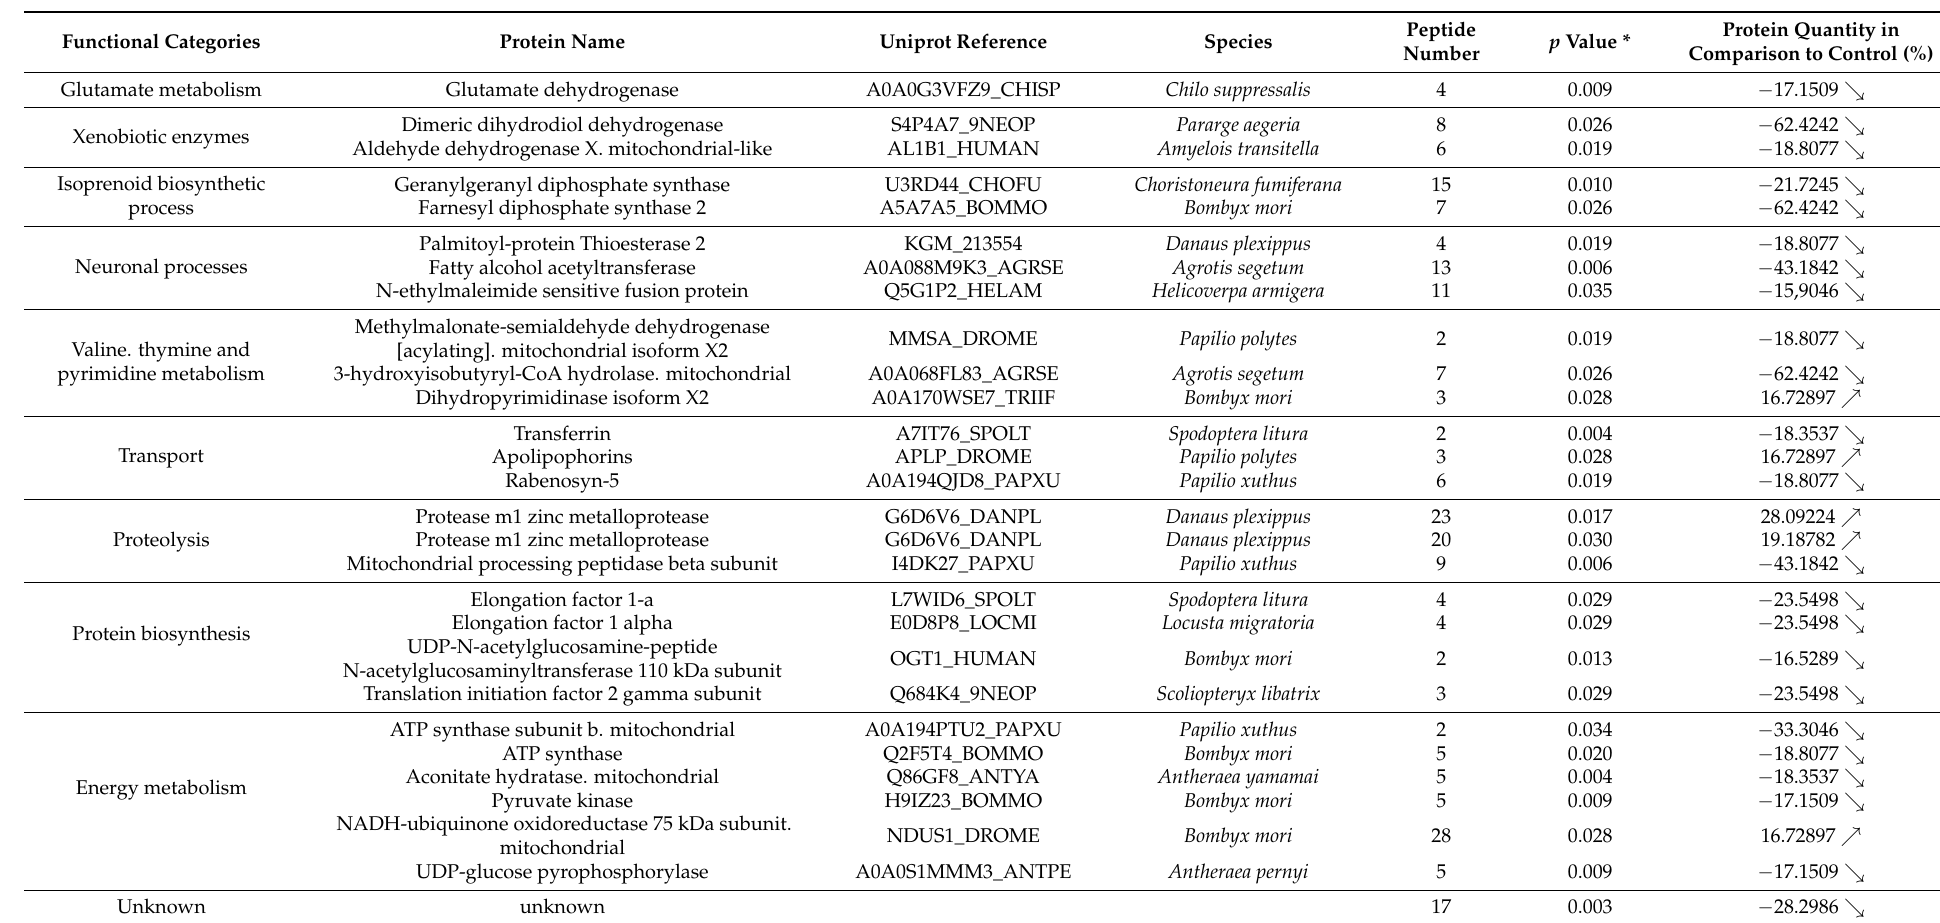
Table 2. Characterization of differentially abundant proteins in the brain of A. ipsilon following clothianidin